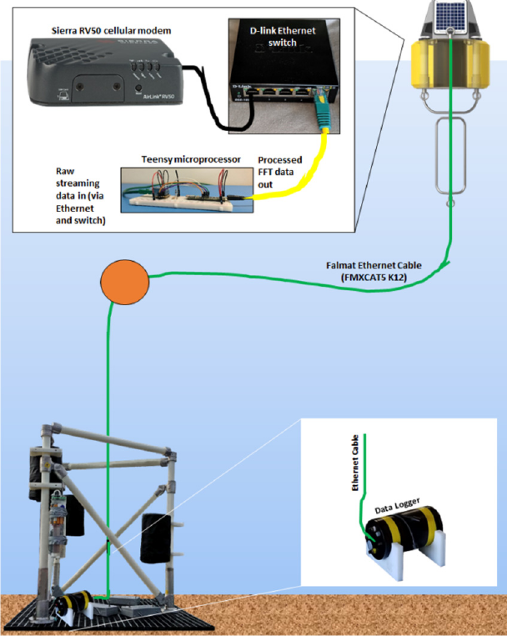
Figure 1. Schematic of NoiseSpotter.